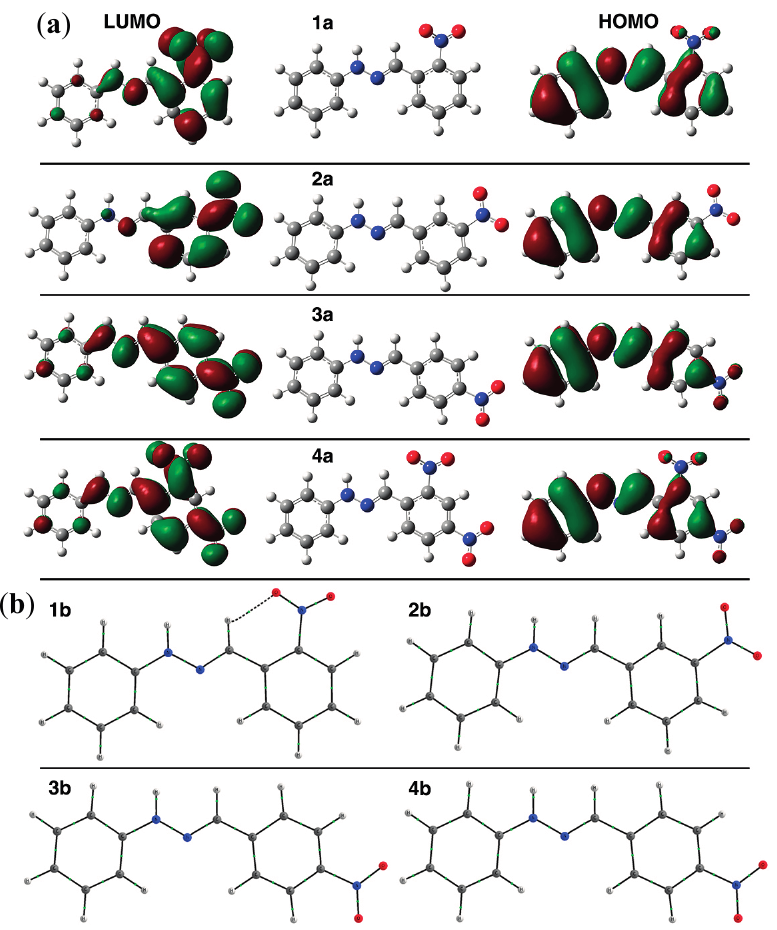
Figure 3. ( a ) Sketches for HOMO and LUMO orbitals of compounds 1 – 4 . The right side of the plot shows the LUMO orbital of the molecules; the left side shows the HOMO orbital; ( b ) QTAIM analysis showing the bond paths between the azomethine hydrogen atoms and the nitro groups.